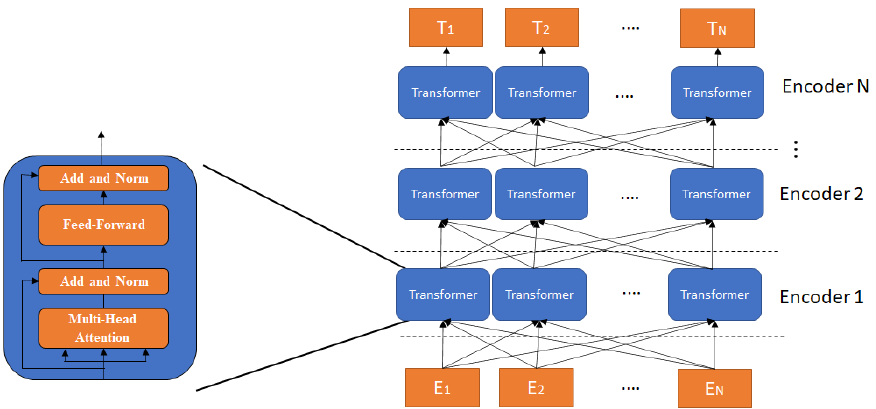
Figure 2. The bidirectional BART encoder architecture.